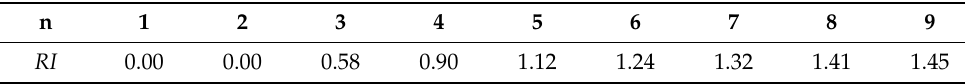
Table 2. Values of the average stochastic coherence